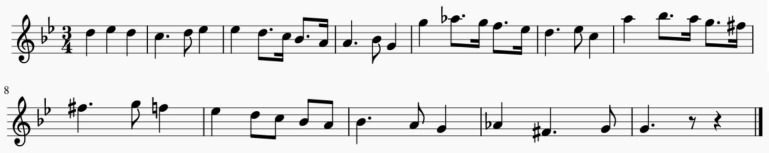
Notation of melody C (2).